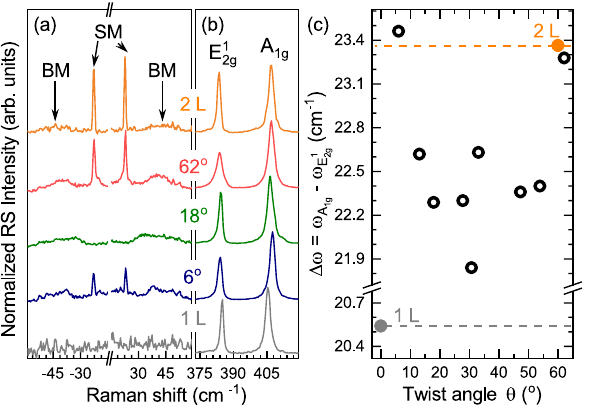
Figure 2. Normalized room-temperature Raman scattering spectra of thin layers MoS 2 : monolayer (1 L), bilayer (2 L) and selected homobilayers with twist angles of 6 ◦ , 18 ◦ and 62 ◦ in the energy range of ( a ) interlayer and ( b ) intralayer vibrations measured under excitation of 2.41 eV laser light. The spectra are normalized to the intensity of the A 1g peak. ( c ) The energy separation between the A 1g and E 1 2g peaks, i.e. �ω = ω A function of twist angle ( θ ) for all the studied twisted homobilayers. The corresponding �ω for 1 L and 2 Ls, represented by solid symbols, are also shown.